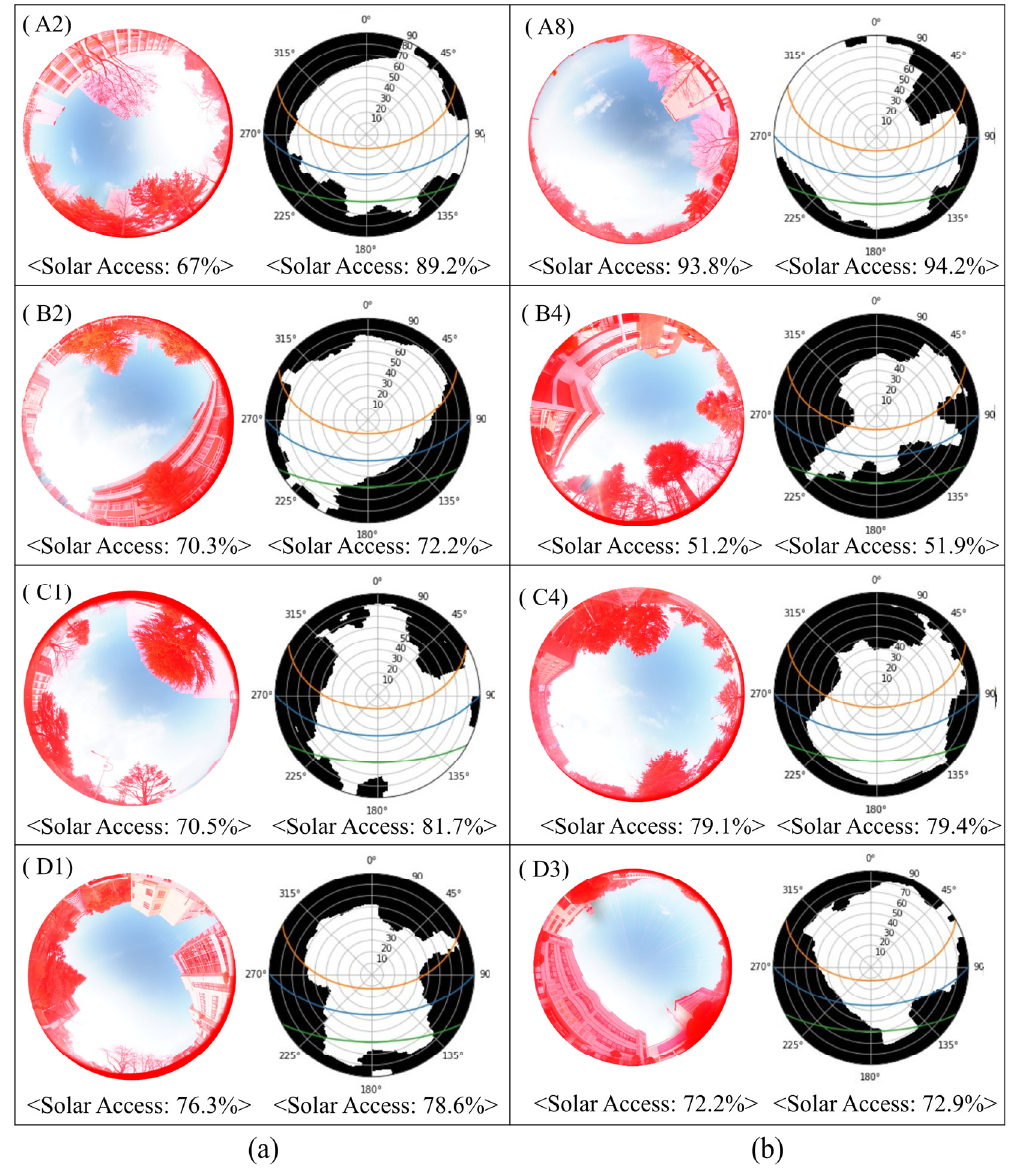
Figure 11. Polar image comparison of image analysis and 3D analysis. ( a ) The points ( A2 , B2 , C1 , D1 ) where the deviation of the analysis result is large, and ( b ) the points ( A8 , B4 , C4 , D3 ) where the deviation is small.